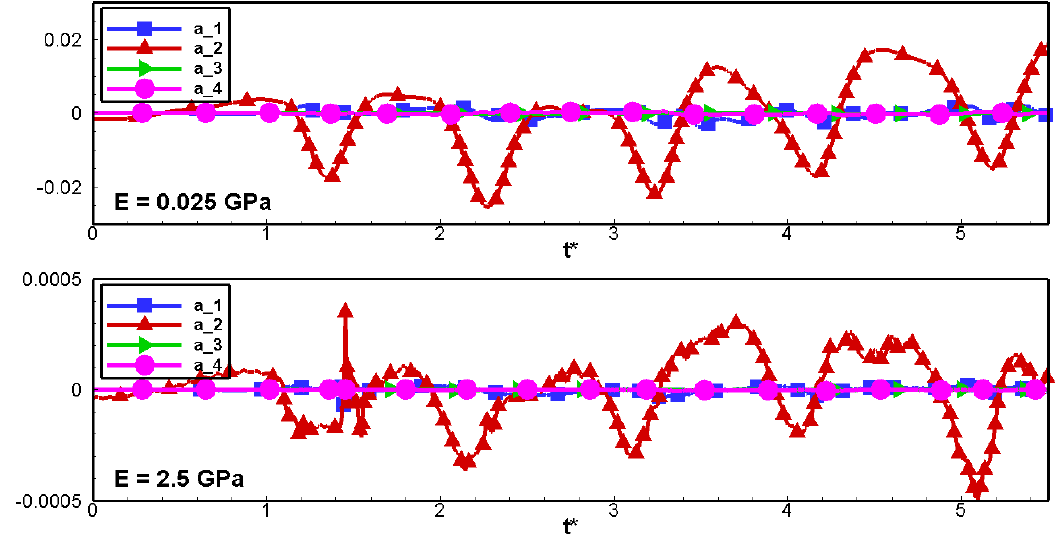
Figure 11. Amplitude of the vibration modes of the plate with Young modulus E = 2.5 GPa under severe wave conditions with wave steepness ka = 0.5. Ratio of the plate length to the wavelength is 2 L / λ =